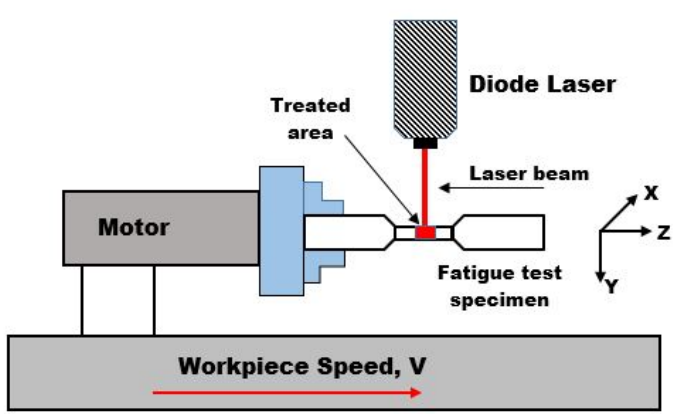
Figure 1. Specimen geometry.